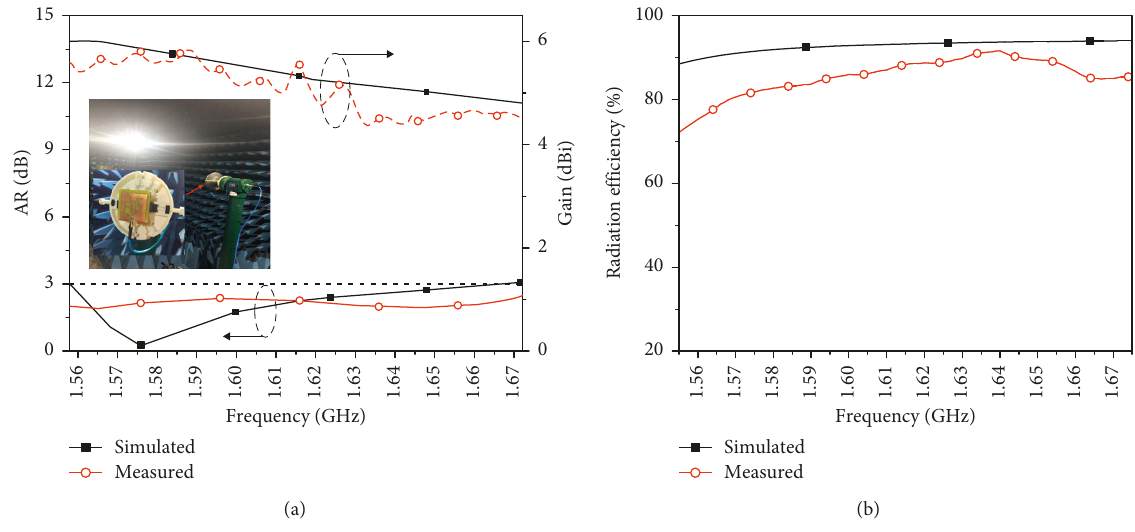
Figure 12: Measured and simulated results of (a) gain and AR at the boresight and (b) radiation Figure 13. In all cases, the measured and simulated results have good corroborations.